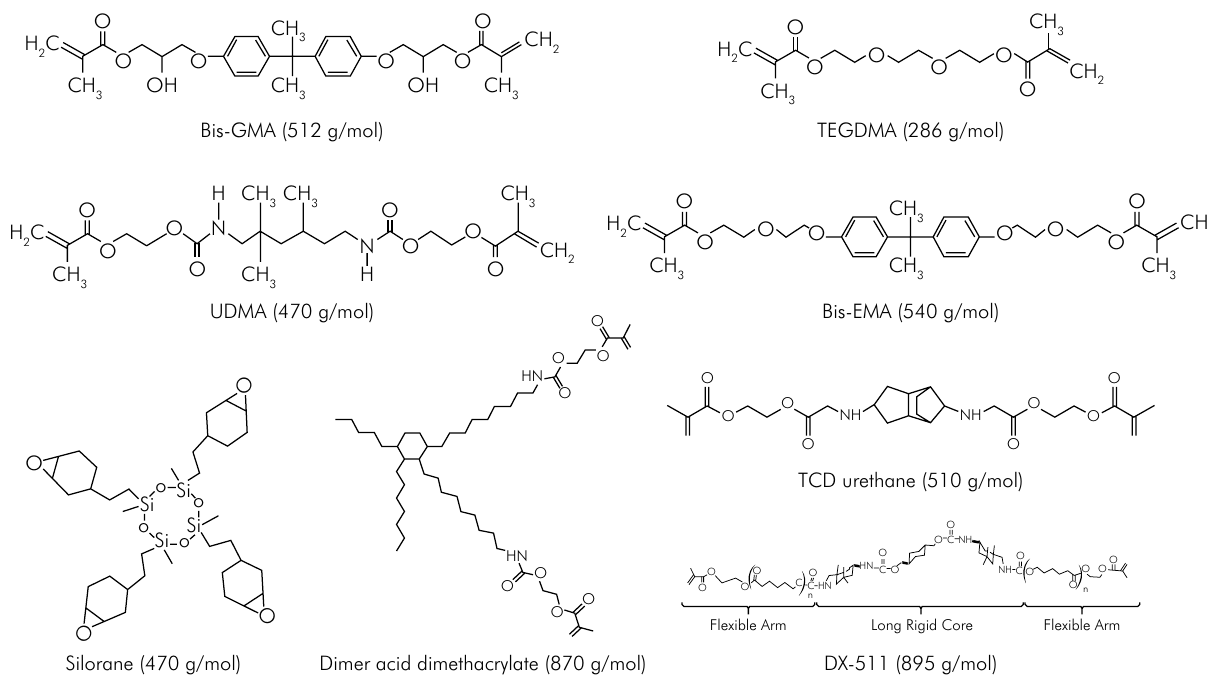
Figure 5. Structural formula of base-monomers. Formulas provided by the respective